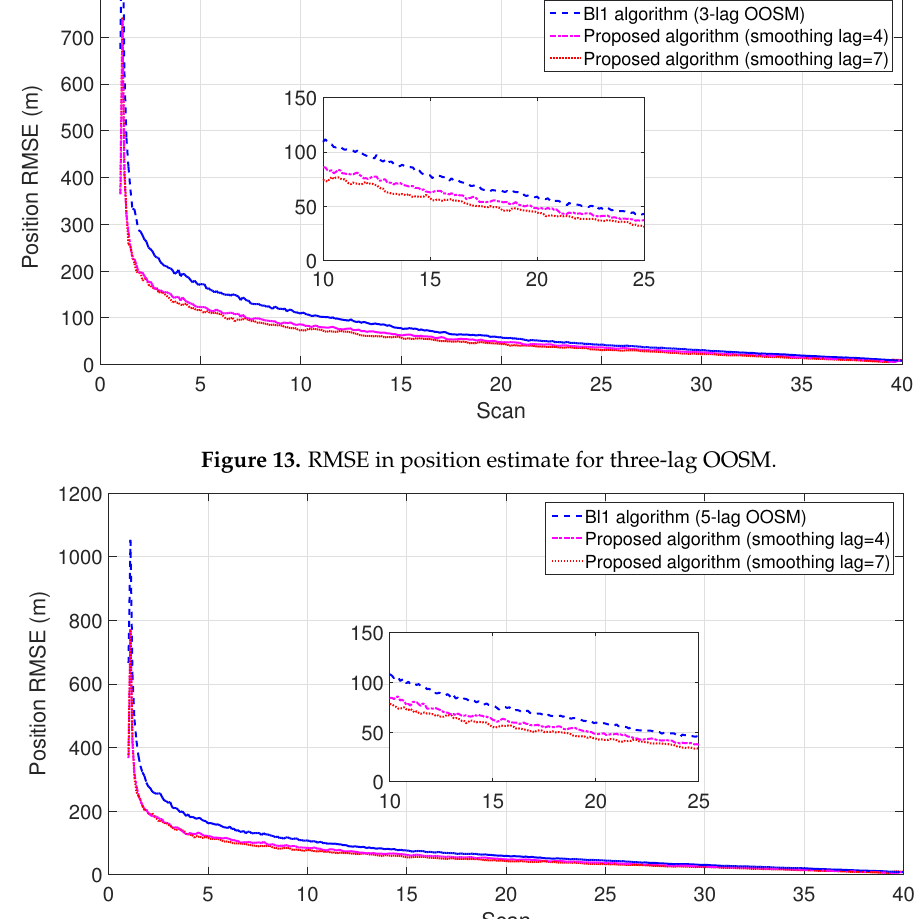
Scan Figure 14. RMSE in position estimate for five-lag